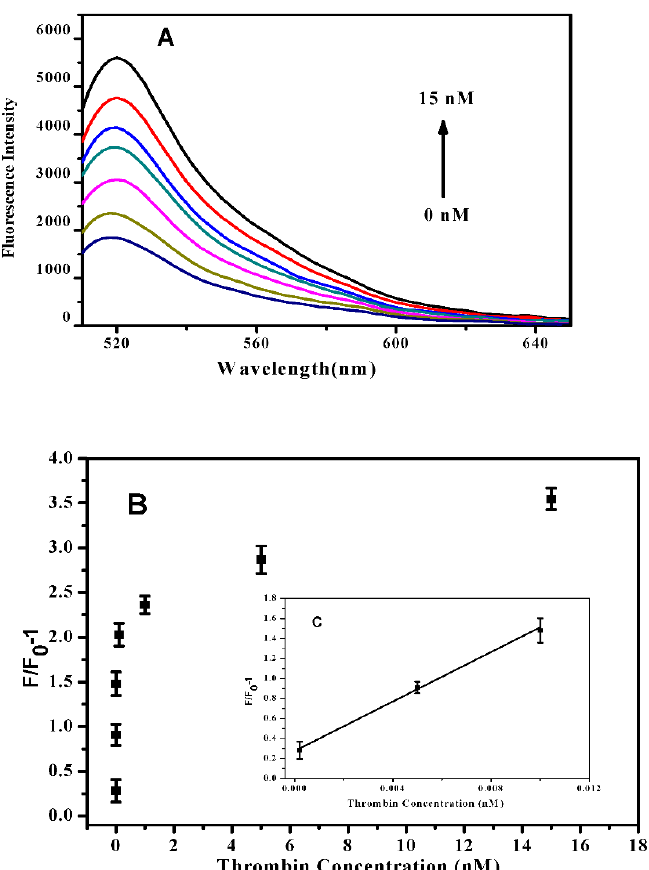
Figure 4. ( A ) The detection of different concentrations of thrombin from bottom to top (0.0002, 0.05, 0.01,1, 5, and 15 nM) using the GO-DNA sensor; ( B ) the values of F/F 0 -1 for the assay with the concentrations of thrombin; ( C ) the values of F/F 0 -1 for the detection of thrombin. The number of samples was 5.